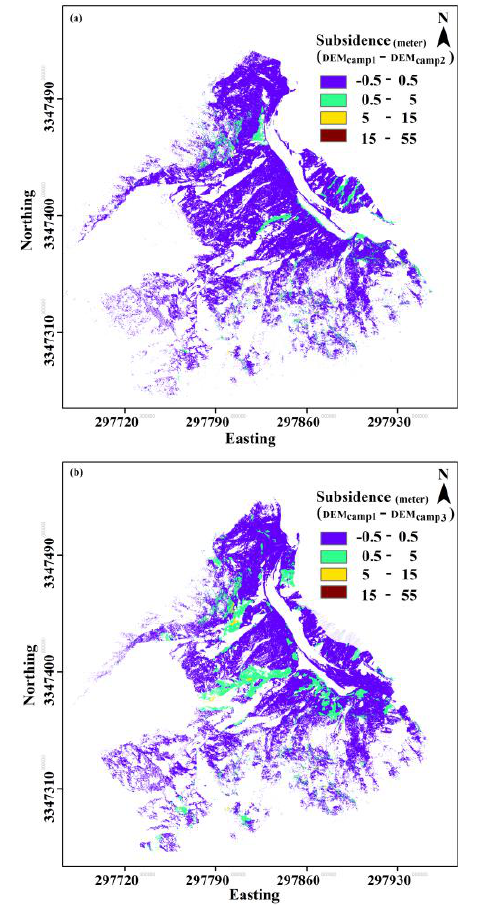
Figure 3. TLS DEM differences for (a) epoch difference 1-2 and